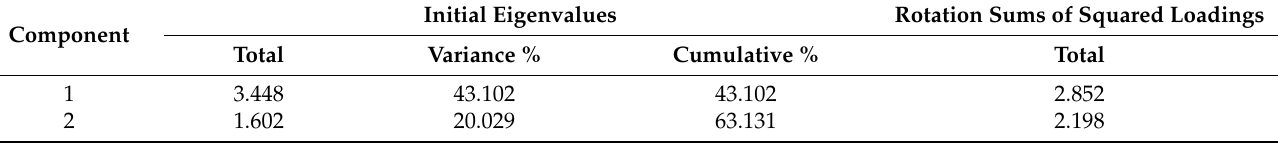
Table 2. Factor analysis for construct